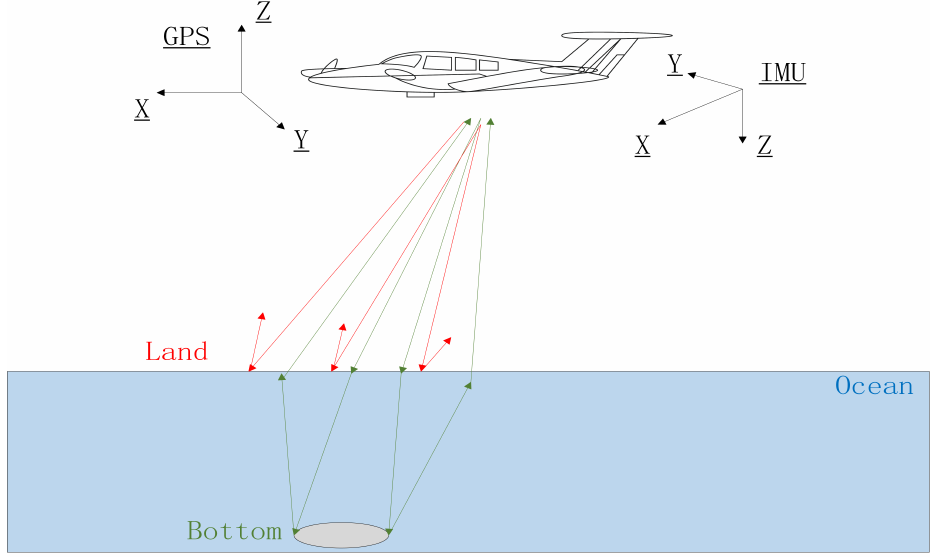
Figure 1. Diagram of waveform reflected from